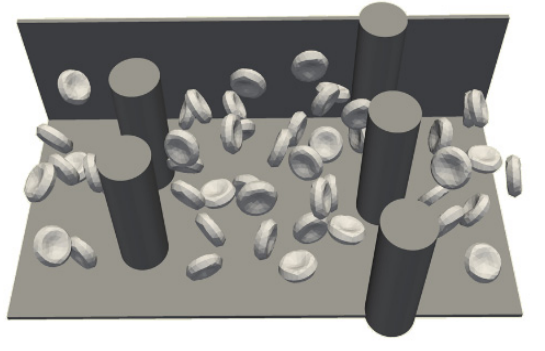
Fig. 10. Geometry A with 50 randomly distributed red blood cells.